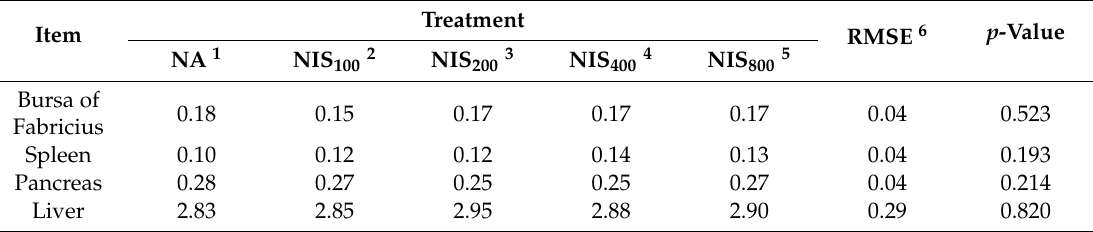
Table 10. The e ff ect of dietary supplementation of nisin on the selected internal organs of broiler chickens, Experiment